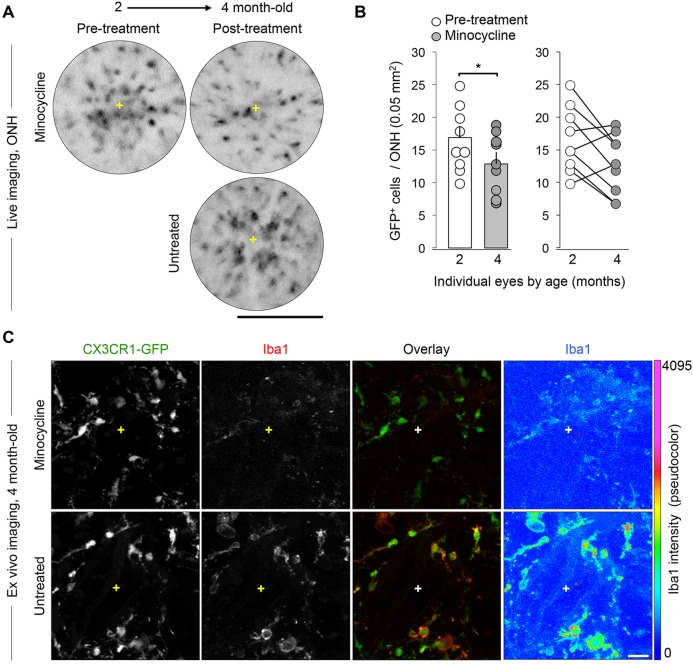
Induced decreases in local microgliosis are detectable by live imaging. (A) Live cSLO images of the same ONH before and after oral minocycline treatment (mouse was 2 and 4 months old, respectively) showing a reduction in GFP+ cell clustering, compared to an age-matched untreated control representing moderate microgliosis. (B) Total number of cells per ONH at 2 and 4 months of age (n=9 eyes represented by circles) plotted before and after minocycline treatment showing a significant mean reduction post-treatment (*P<0.05; Student's t-test). Bars indicate mean±s.e.m. at each age (16.9±1.65 cells per 0.05 mm2 and 13±1.53, respectively). The graph to the right depicts with lines the drop in microgliosis in 6/9 individual ONHs. (C) Ex vivo immunostaining of the same 4-month-old ONHs shown in A revealing that there is a noticeable downregulation of Iba1 expression, but not of GFP, after minocycline treatment, as visible in the single-channel view of Iba1 and its pseudocolor coding by expression intensity. Each image shows a maximum intensity projection of 50 µm and represents the ONH area. Scale bars: 250 µm (A), 25 µm (C).